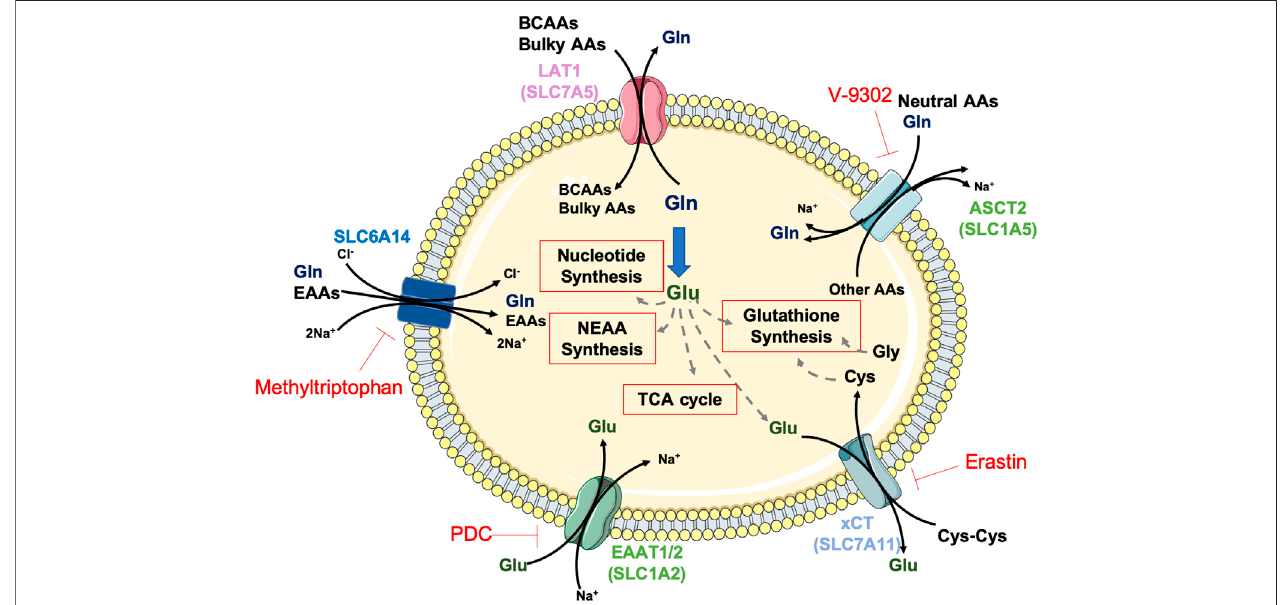
FIGURE 1 | Amino acid transporters and metabolism in aggressive cancers. The amino acids (AAs) glutamate (Glu, dark green) and glutamine (Gln, dark blue) are key players for amino acid transport and global cellular metabolism in PDAC, HCC and GBM tumours. Glutamine transported into the tumour cells by the transporters SLC6A14 or ASCT2 is metabolised to glutamate via glutaminolysis or serves as substrate for the antiport of branched-chain (BCAAs) and bulky amino acids via LAT1. Glutamate facilitates cysteine (Cys) uptake via xCT or supports key energy and biosynthetic pathways, such as glutathione, non-essential AA and nucleotides synthesis or TCA cycle anaplerosis. Depicted in red, AA transporters